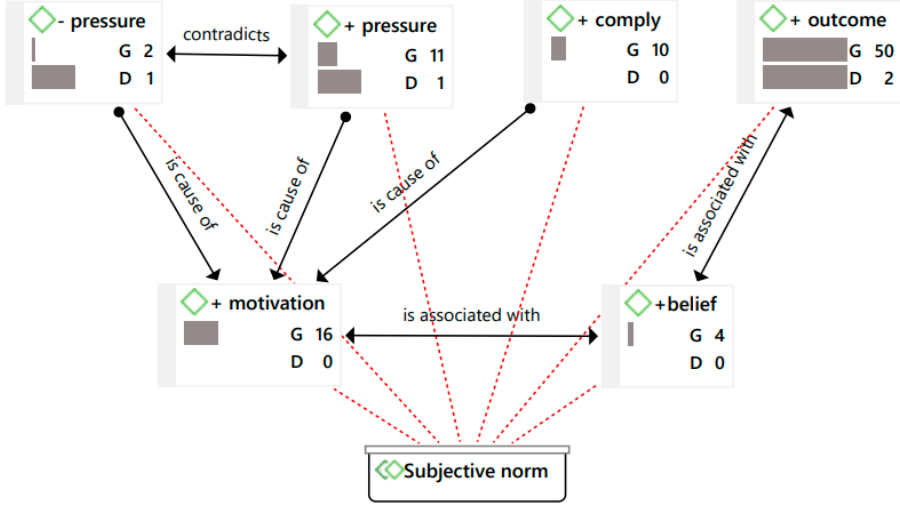
Figure 3. The participants’ perception on the norms they follow (source: